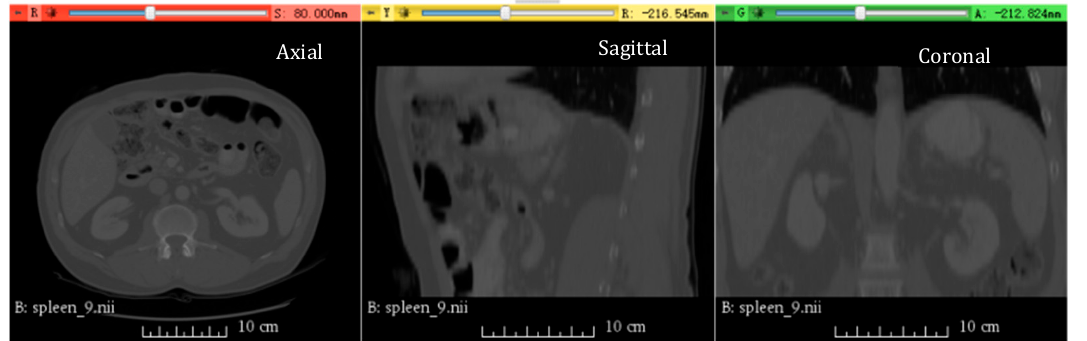
Figure 7. A sample of the Spleen data shown in axial, sagittal, and coronal plane views from left to right. The axial view was chosen in this paper.